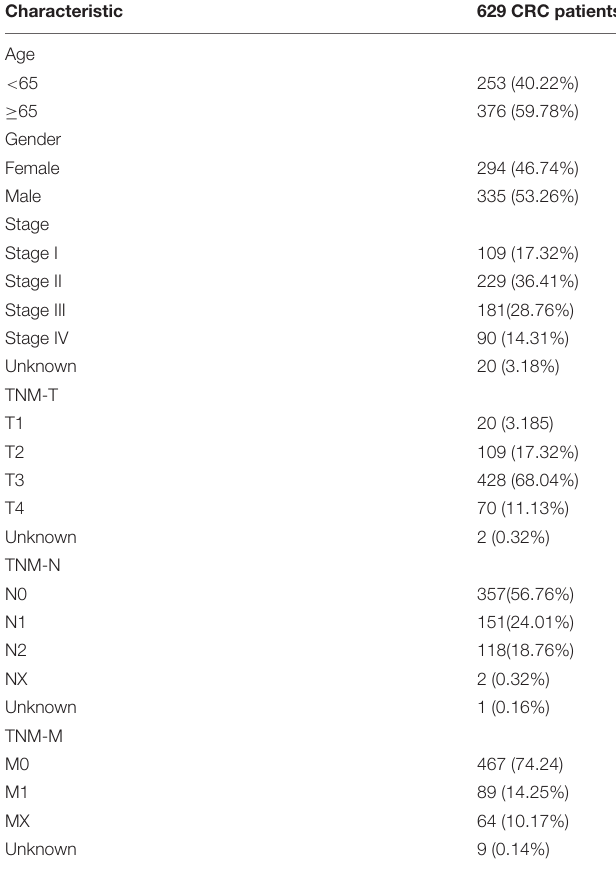
TABLE 1 | Clinical characteristics of patients with colorectal cancer (CRC) in The Cancer Genome Atlas (TCGA).